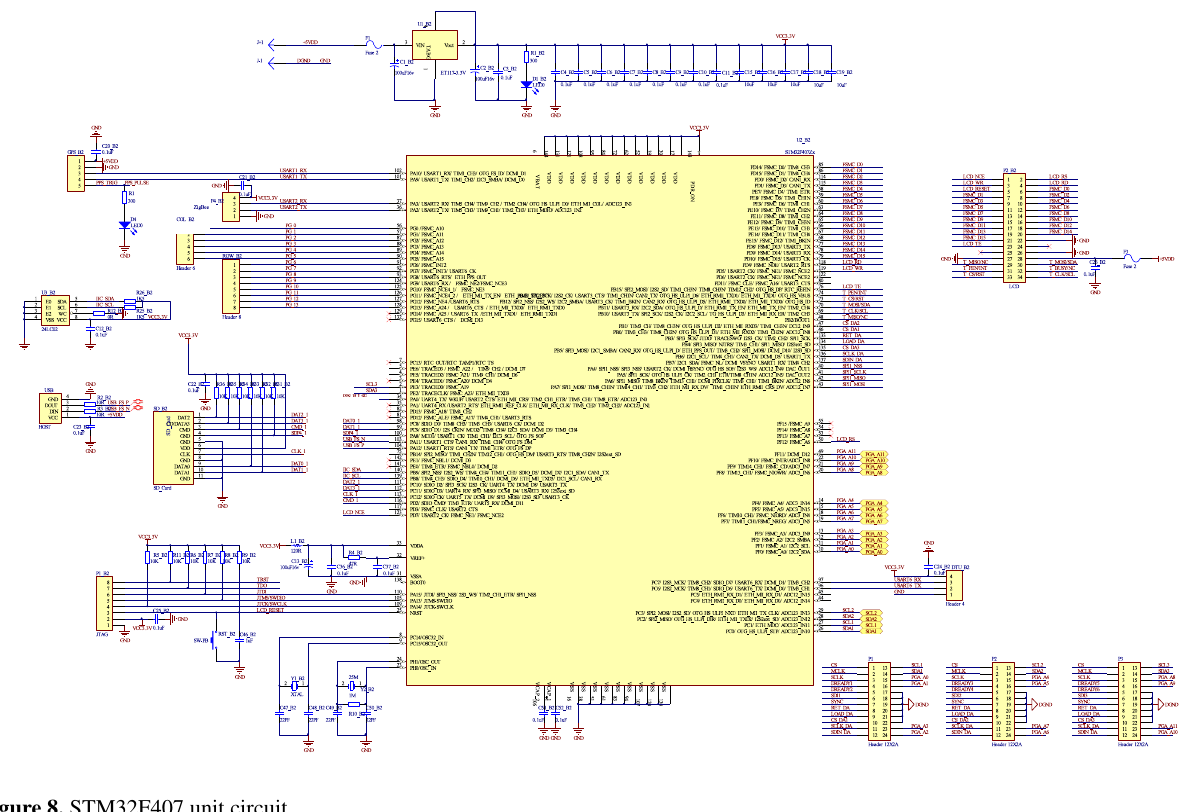
Figure 8. STM32F407 unit circuit. Table 2. Error analysis of interchannel